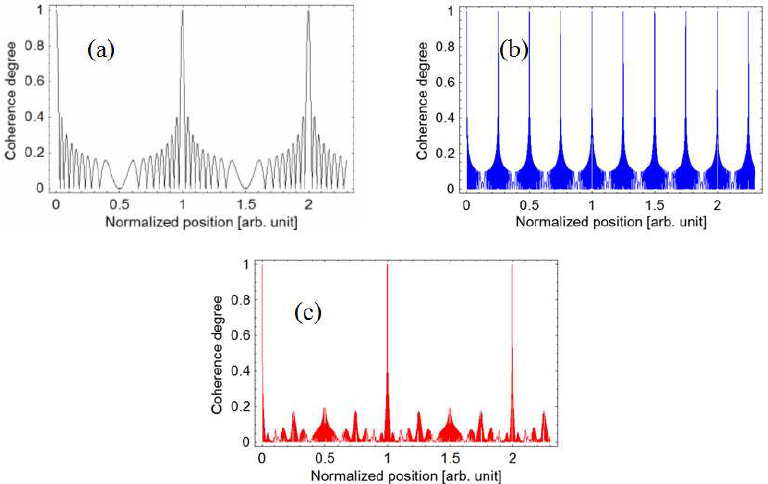
Figure 36. Simplified explanation of the double modulation scheme to elongate the measurement range [55]. ( a – c ) show, respectively, the synthesized coherence functions for the FM frequency of f 0 , 4 f 0 , and f 0 with 4 f 0 .